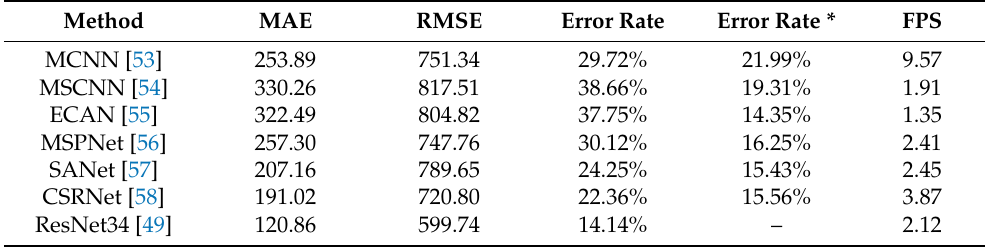
Table 2. Comparison with other algorithms: we compared the current mainstream crowd density estimation algorithms, and our algorithm has the highest accuracy.